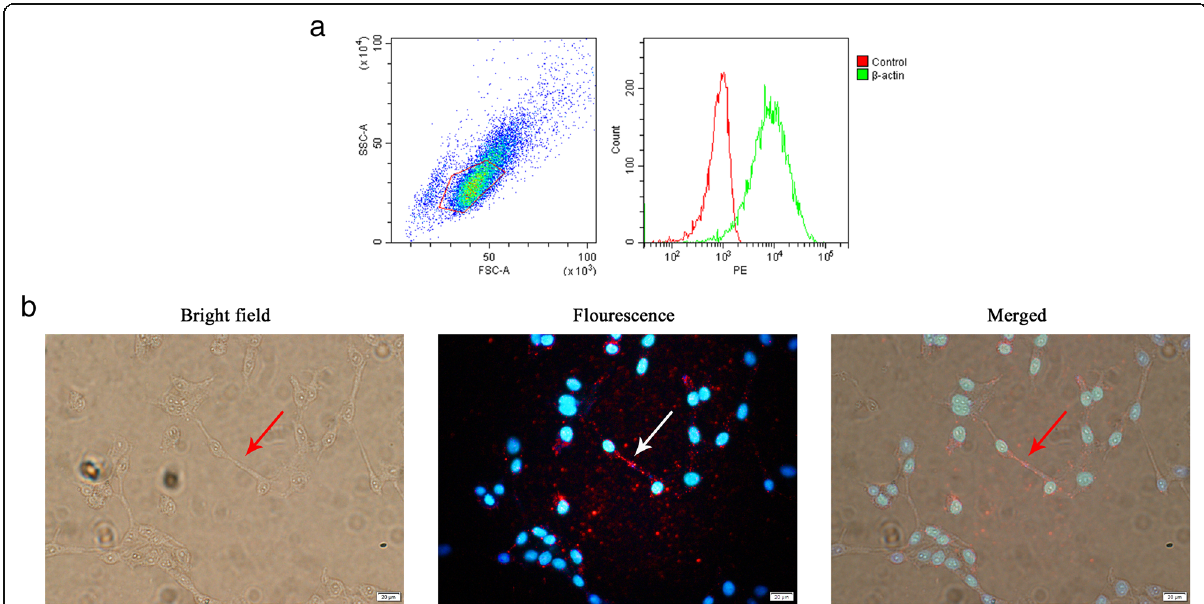
Fig. 5 a Fluorescence analysis for β -actin in HeLa cells. The β -actin group was incubated with mouse anti- β -actin and QDs-IgG (goat anti-mouse), and the control group was incubated with BSA and QDs-IgG. The control group can allow for the exclusion of the background fluorescence caused by the nonspecific adsorption of QDs-IgG. b Fluorescence microscope images of HeLa cells under UV-vis irradiation. DAPI stained the cell nuclei and emitted blue fluorescence; QDs-IgG indirectly combined with β -actin and emitted red fluorescence. Scale bar 20 μ